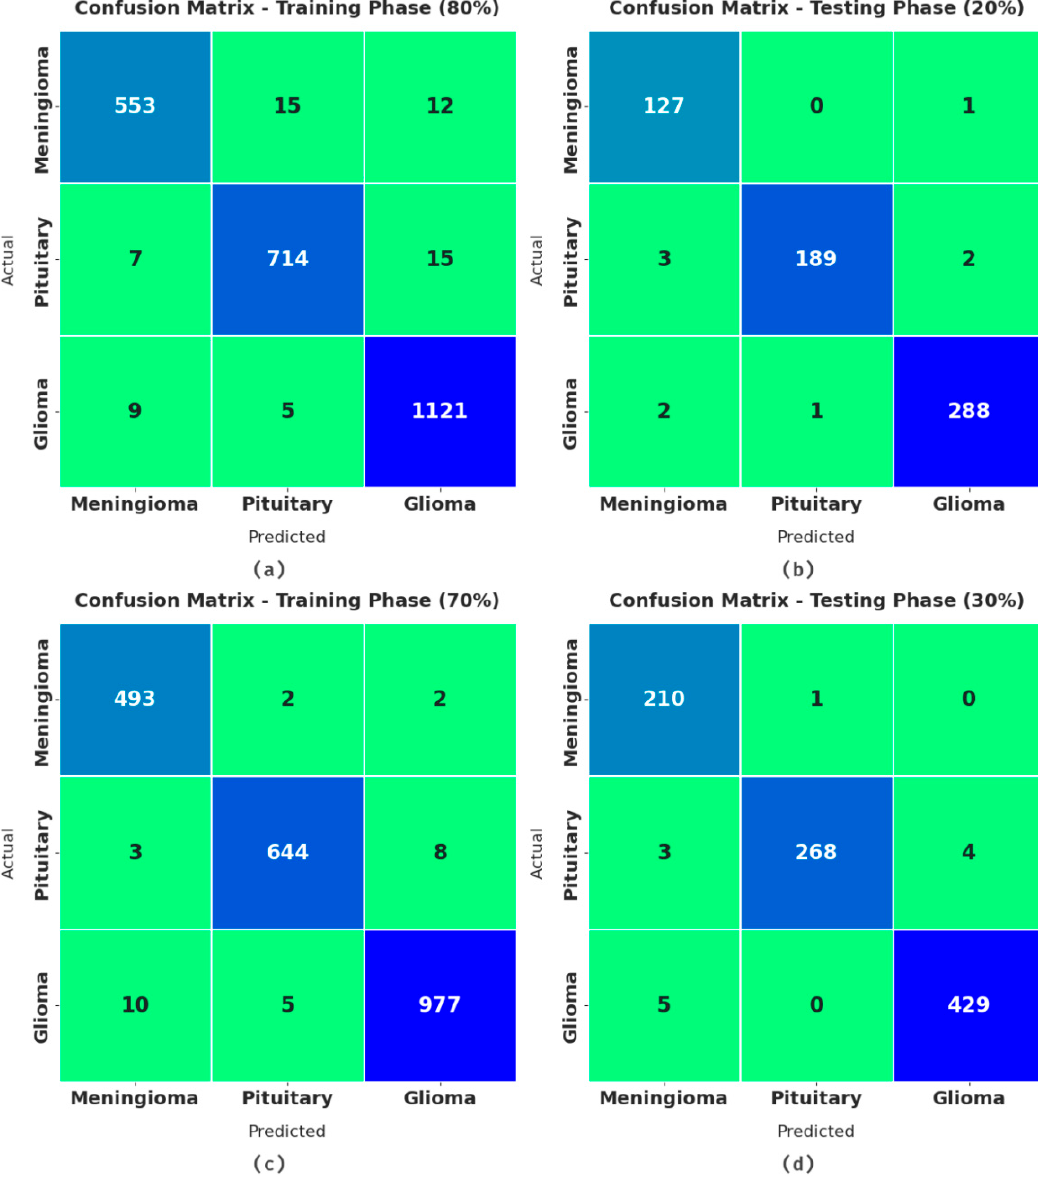
Figure 4. Confusion matrices of EADL-BTMIC technique ( a ) 80% of TR data, ( b ) 20% of TS data, ( c ) 70% of TR data, and ( d ) 30% of TS data.